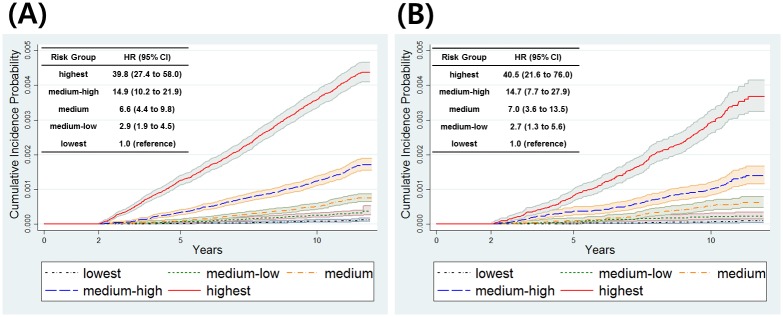
Cumulative incidence probability for five risk groups.(A) men and (B) women.